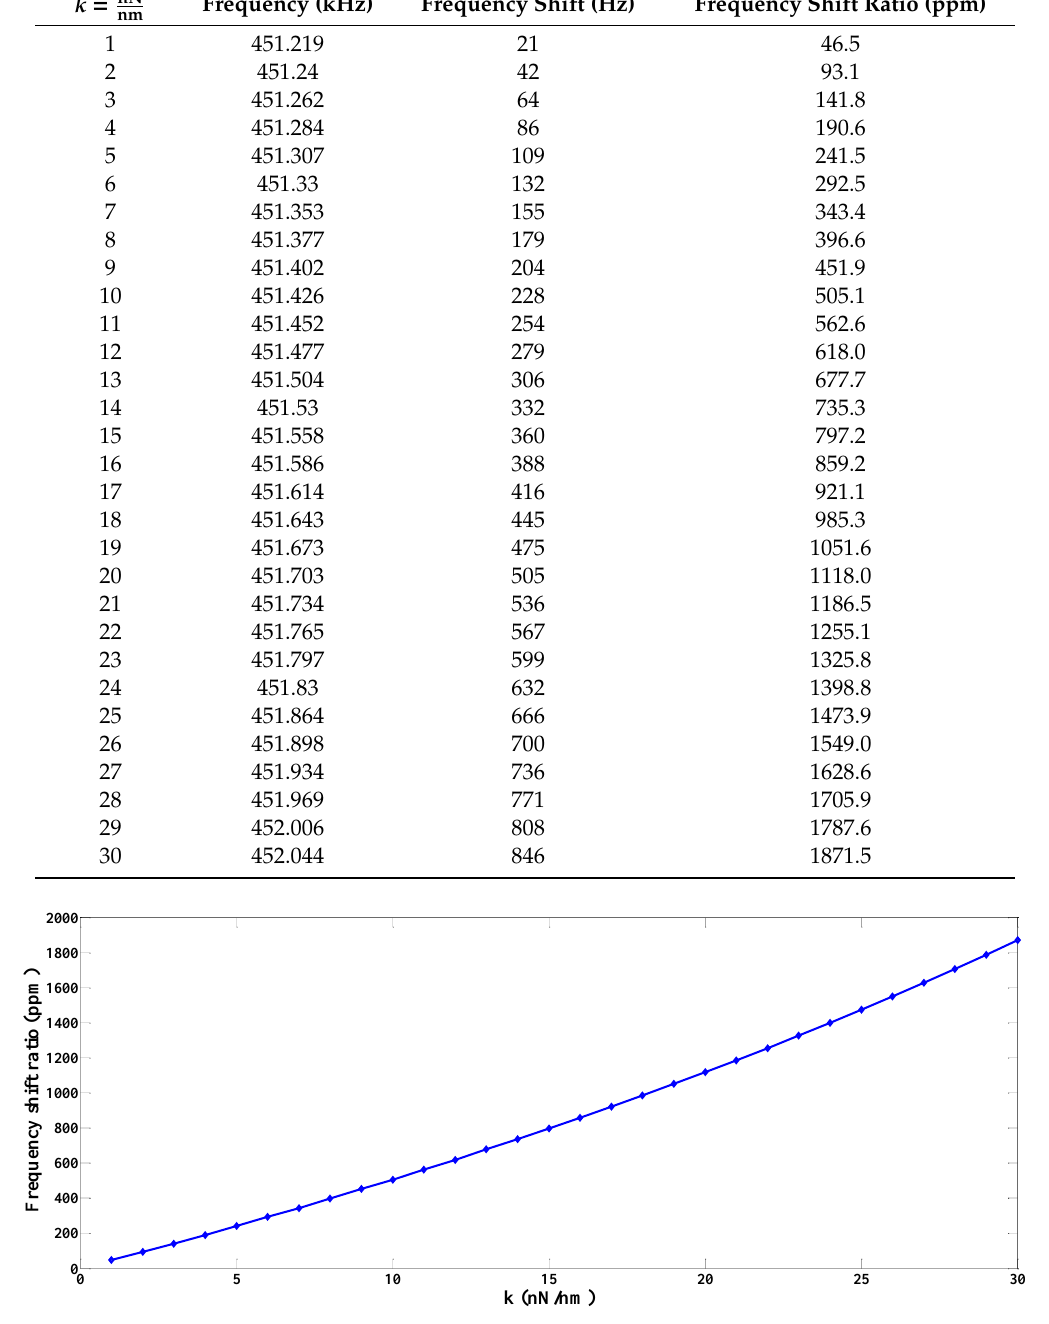
Figure 9. The relationship between the frequency shift and the spring constant.